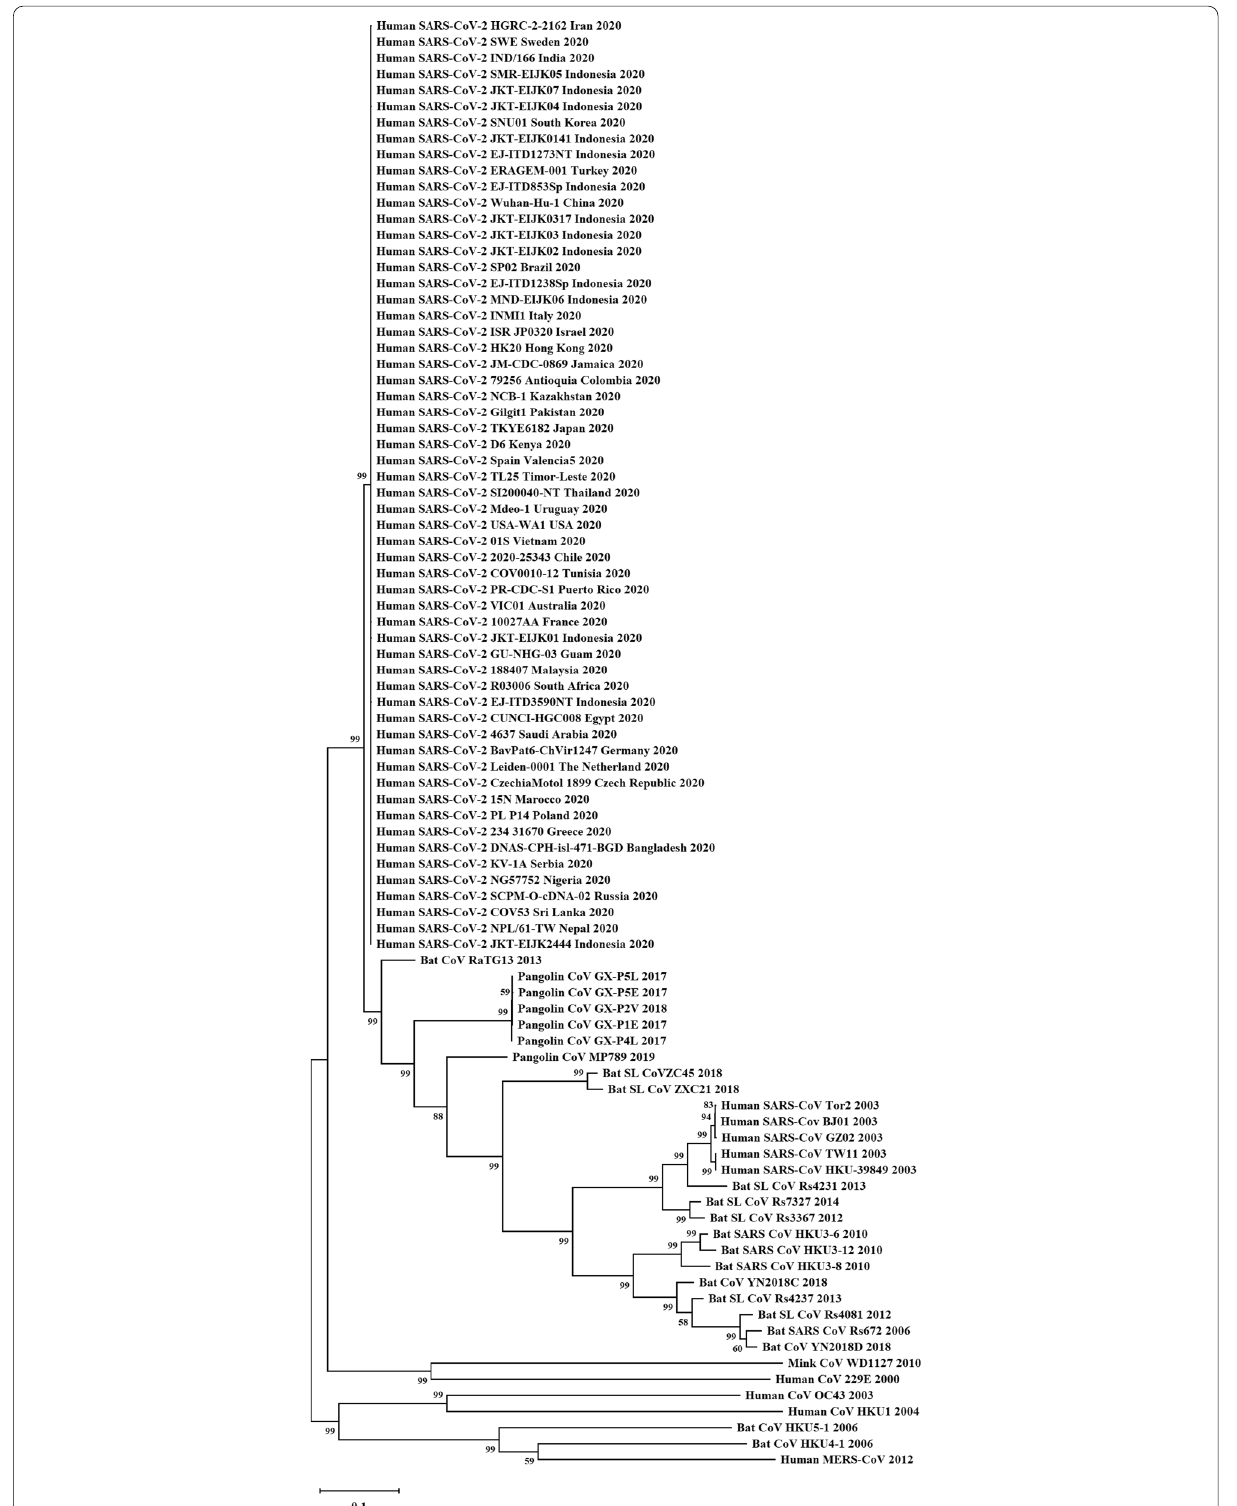
Fig. 3 Molecular phylogenetic of SARS-CoV-2 isolates and other coronaviruses. Indonesian SARS-CoV-2 isolates and other SARS-CoV-2 isolates from various countries are grouping into a clade and closely related to CoV RATG13 from bats, CoV from pangolin, and SARS-CoV from human,